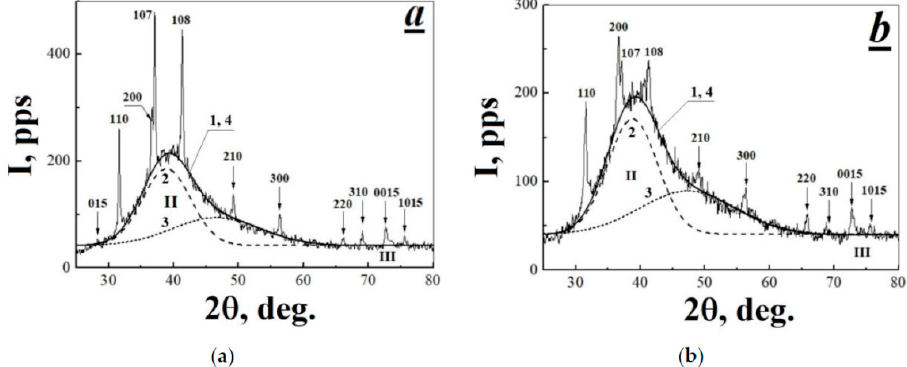
Figure 4. Diffraction patterns of the ( a ) initial and ( b ) thermal-radiation-modified polytetrafluoroethylene samples in the range of diffraction angles 2 θ = 5°–25°: (II) and (III) are the diffuse diffraction maxima in ranges of 25°–70° and 72°–75°, respectively; 1 is the experimental dependence; 2 and 3 are the first and second components of the 25°–70° diffuse diffraction maximum established by the nonlinear least-squares method, respectively; and 4 is the approximation. Arrows and numbers indicate the diffraction maxima found in the X-ray scattering spectra of the initial and thermal-radiation-modified polytetrafluoroethylene.